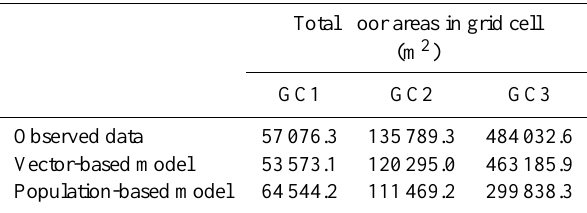
Table 3. Total residential building floor areas for cells GC1, GC2 and